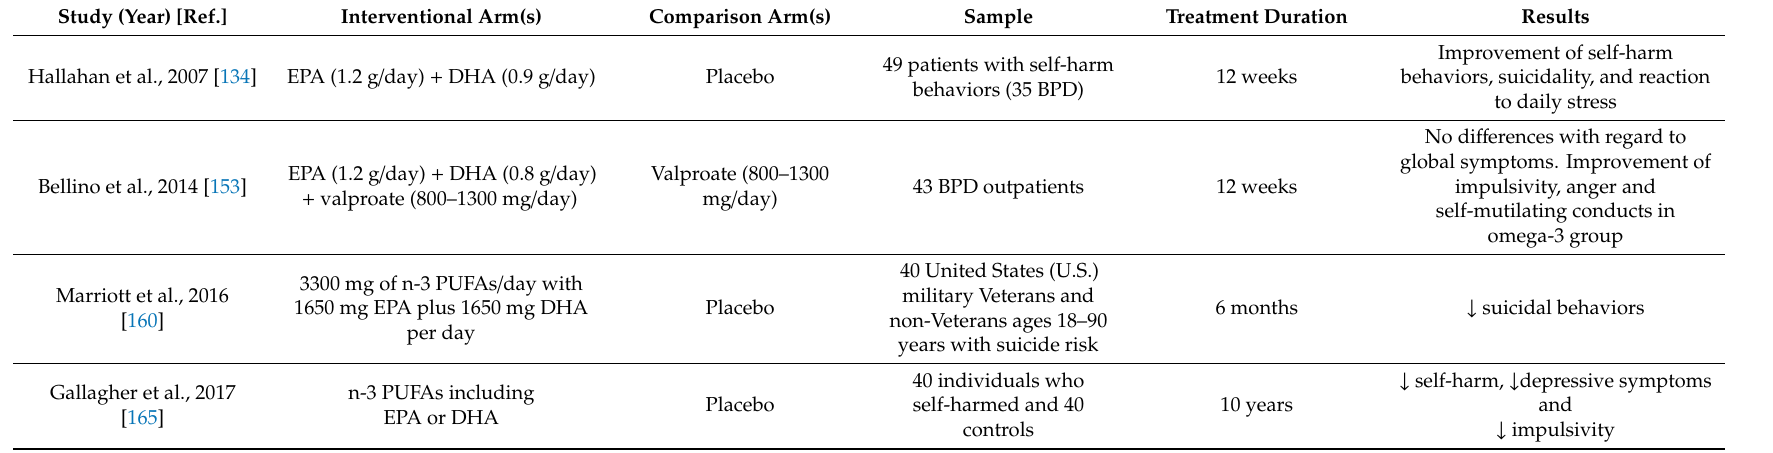
Table 4. Randomized controlled trials and open trials of omega-3 PUFAs on self-harm